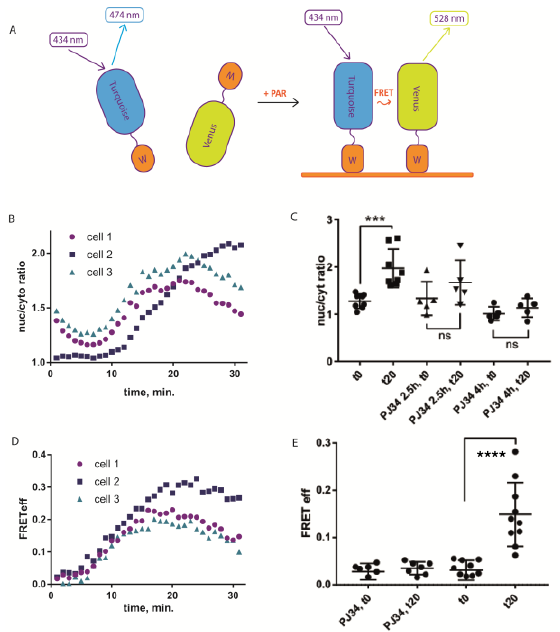
Figure 1. Sensor for PAR relying on WWE (sPARroW) response to PAR accumulation stimulus. ( A ) Principle of action of the sensor. ( B ) Time-lapse detection of sPARroW fluorescence distribution between nucleus and cytoplasm after H 2 O 2 treatment. ( C ) End-point detection of sPARroW fluorescence distribution between nucleus and cytoplasm after H 2 O 2 treatment with and without pretreatment with the PARP inhibitor (squares – w/o inhibitor, triangles – 2.5 h pre-incubation with PJ34, circles – 4h pre-incubation with PJ34. ( D ) Time-lapse detection of sPARroW Förster resonance energy transfer (FRET) efficiency after H 2 O 2 treatment. ( E ) End-point detection of sPARroW FRET efficiency after H 2 O 2 treatment with and without pretreatment with the PARP inhibitor. (B-E) U2OS cells were imaged with confocal scanning microscope in a temperature-controlled chamber set to 37 ◦ C. Mean fluorescence intensity signals from the donor, acceptor, and FRET channels were used to calculate FRET e ffi ciency in selected regions of interest according to the formula in the Methods section. Mean values ± SD are depicted. Statistical significance was assessed with a one-way-ANOVA and Tukey post-test. The level of significance is given with ns = not significant, *** p < 0.001, and **** p <